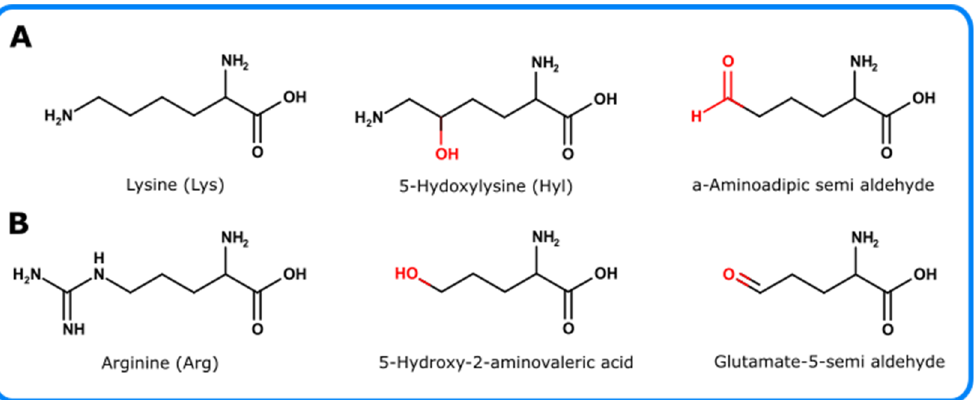
Figure 7. Chemical structures of lysine and arginine together with their photo-oxidation products, 5-Hydroxylysine (Hyl), α-Aminoadipic semi aldehyde, 5-Hydrocy-2-aminovaleric acid, and Glutamate-5-semi aldehyde.